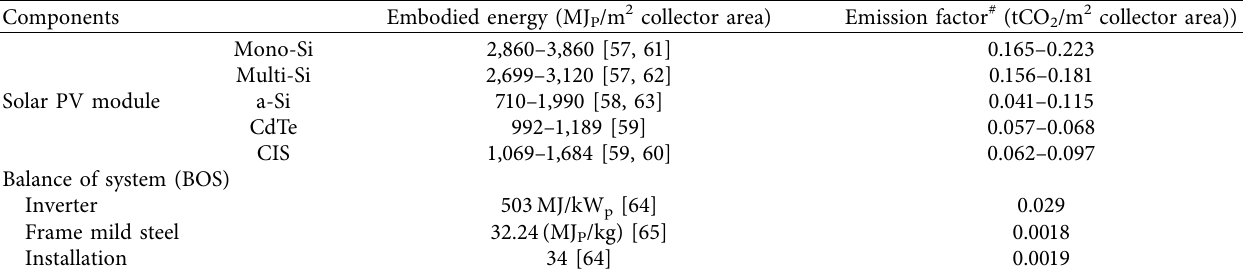
Table 6: Embodied energy of different types of solar PV systems.